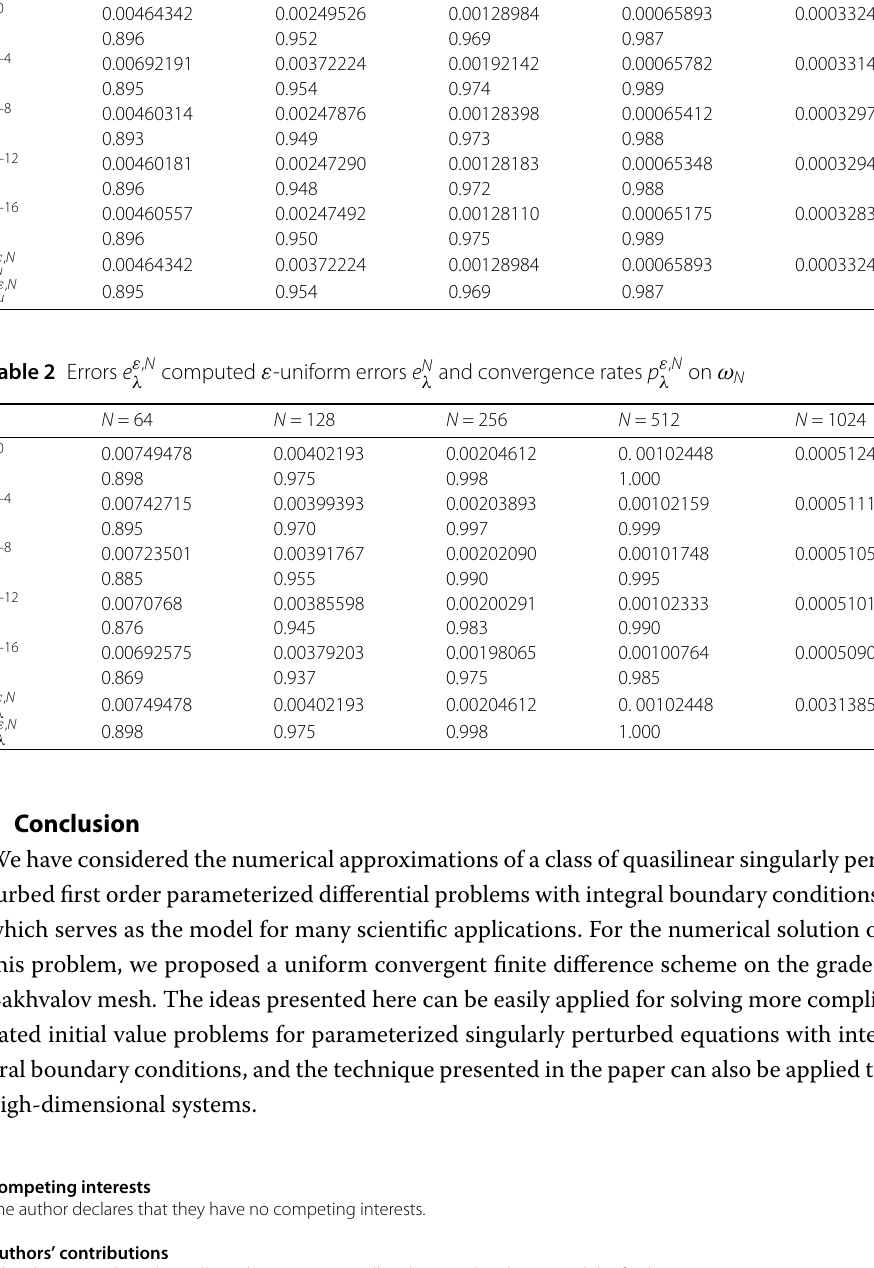
Table 1 Errors e ε , N u computed ε -uniform errors e N u and convergence rates p ε , N u on ω N